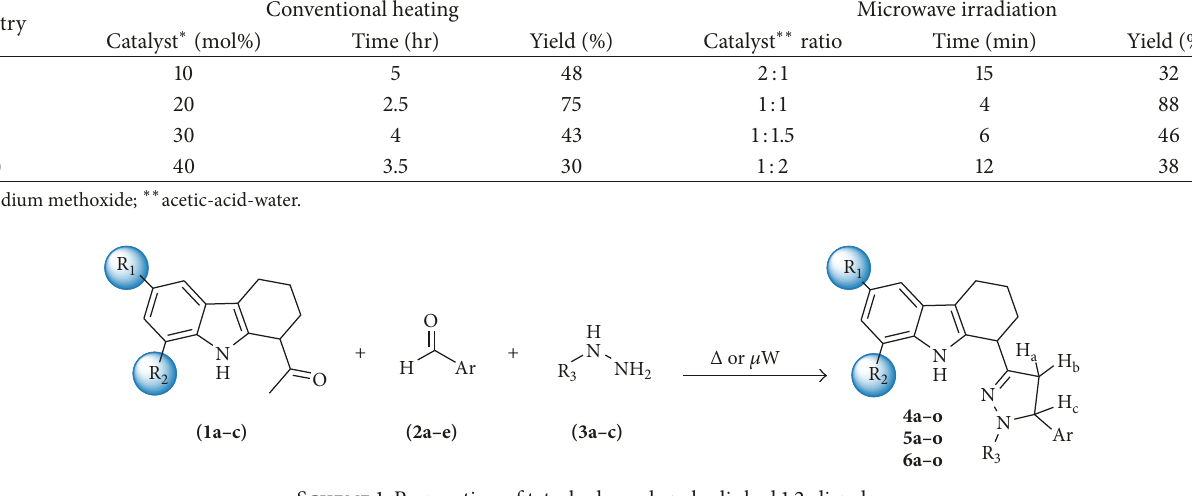
Scheme 1: Preparation of tetrahydrocarbazoles linked